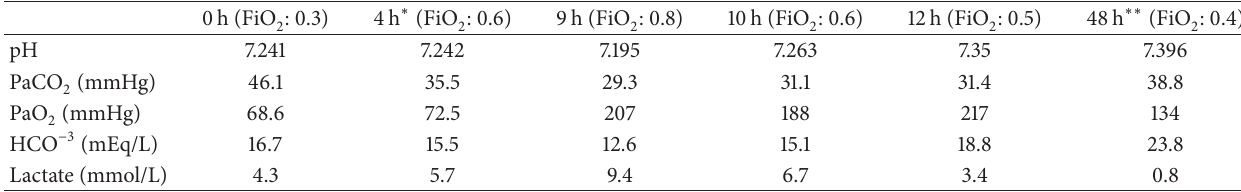
Table 2: Evolution of arterial blood gases in the